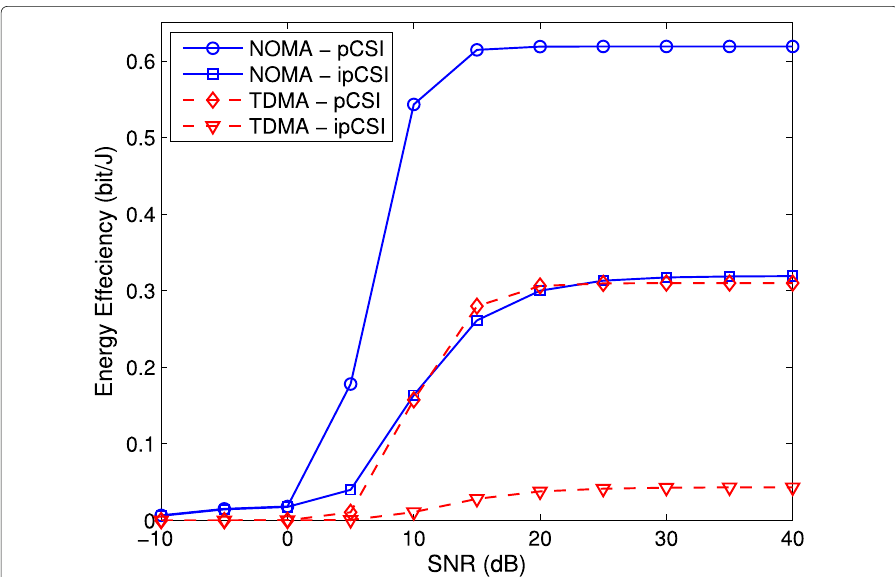
Fig. 5 System energy efficiency versus SNR under ipCSI/pCSI conditions in delay-limited transmission mode, P = 5 W, and T = 1